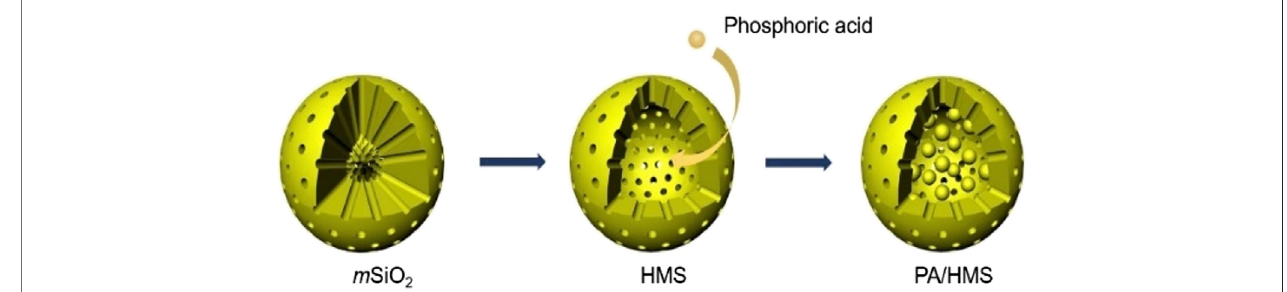
FIGURE 1 | Scheme for the fabrication of PA/HMS composite.